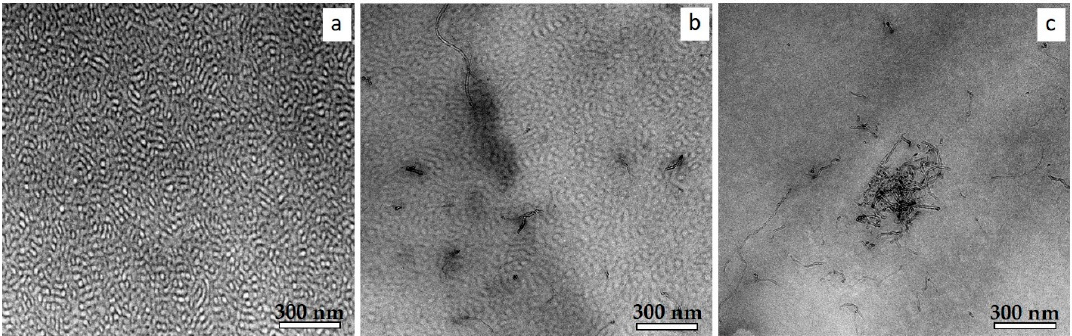
Figure 10. Nanostructured morphology analyzed via TEM of ( a ) 3G55 matrix and ( b ) BCP composite with 0.5 wt % CNT-PS; ( c ) Visualization of MWCNTs in a non-contrasted sample of the BCP/CNT-PS composite.